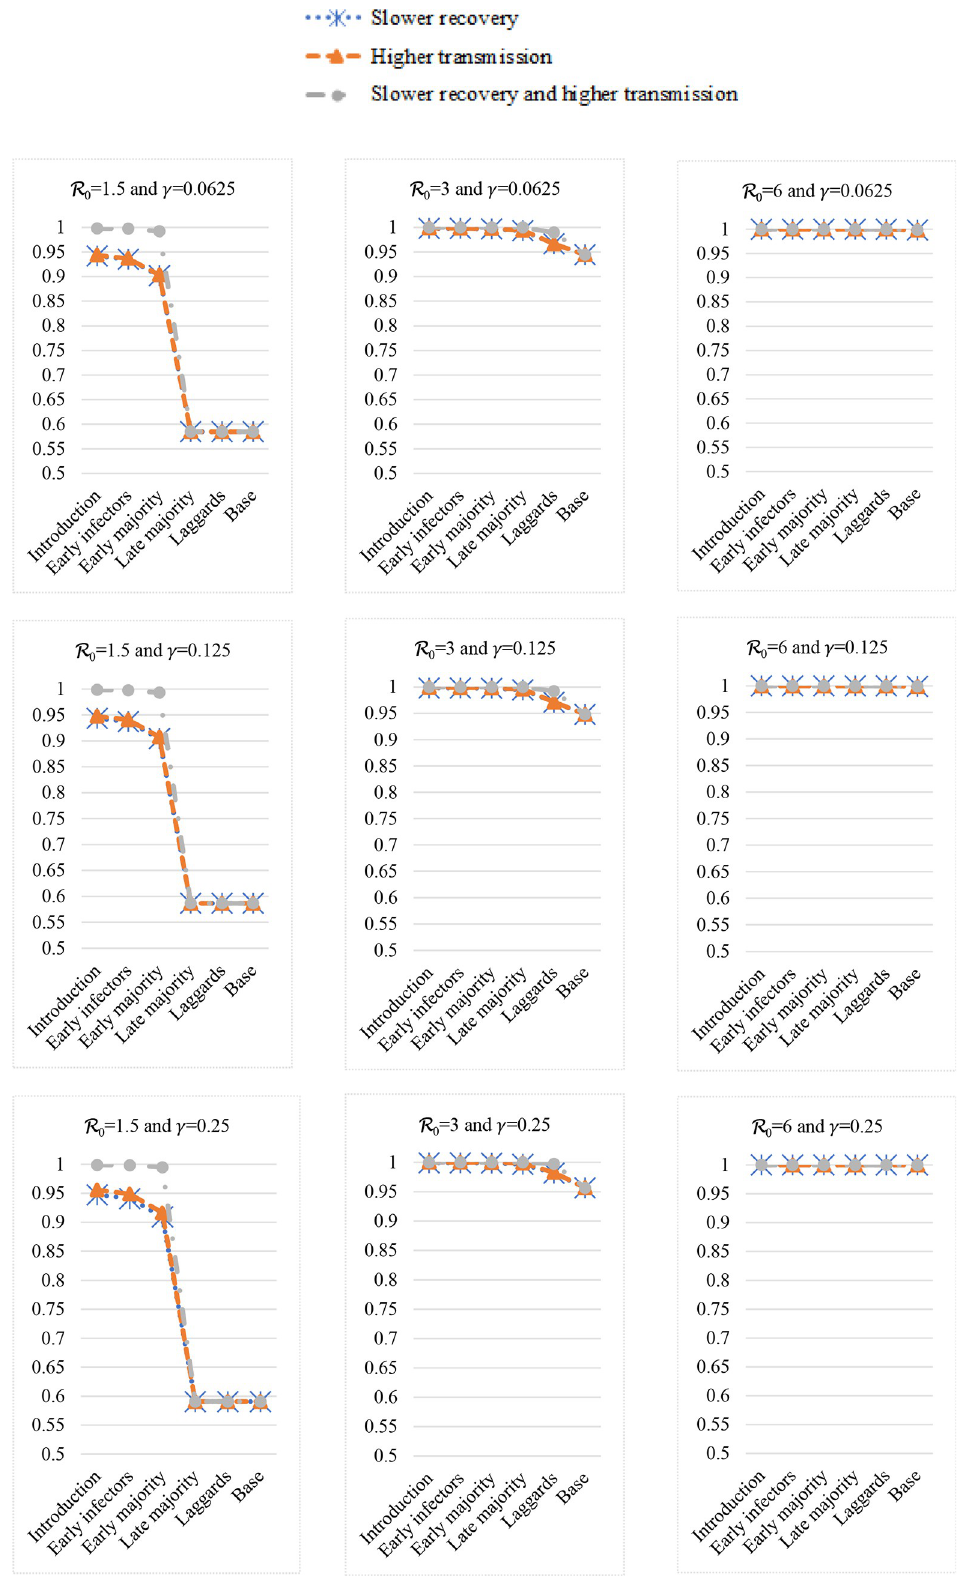
Fig 7. The cumulative infected (i.e., the recovered fractions or total infected) with reopening businesses. https://doi.org/10.1371/journal.pone.0280429.g007 PLOS ONE | https://doi.org/10.1371/journal.pone.0280429 January 26,